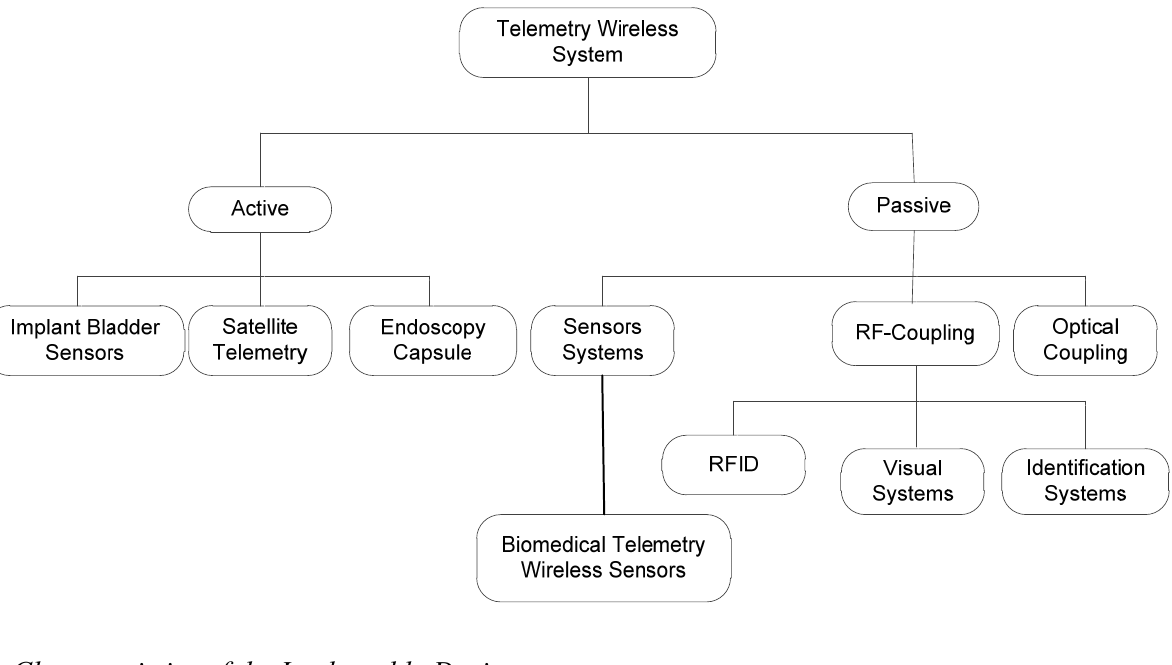
Figure 2. Communication technologies for wireless